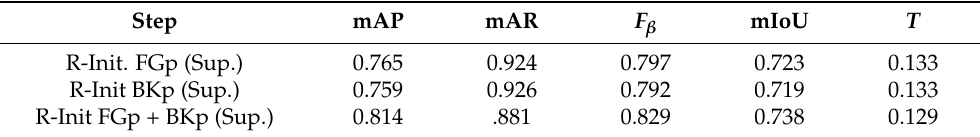
Table 4. Performance of superpixel-wise initialization by CSNet on VOS . FGp: foreground branch, BKp: background branch. Sup. is short for